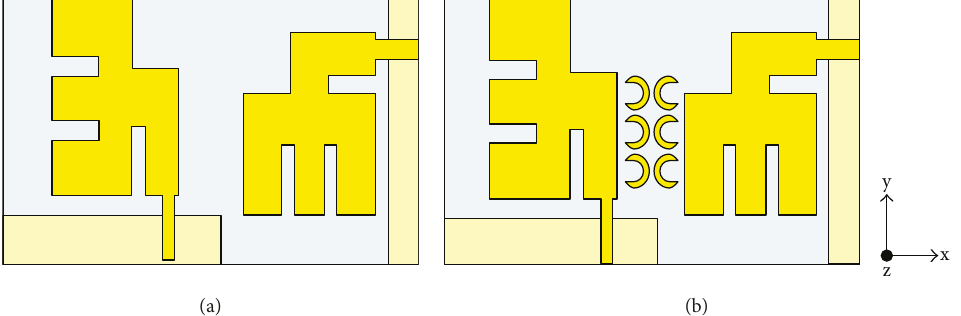
Figure 14: The proposed MIMO system in orthogonal con fi guration, (a) without CSR matrix structure, (b) and with CSR matrix structure.